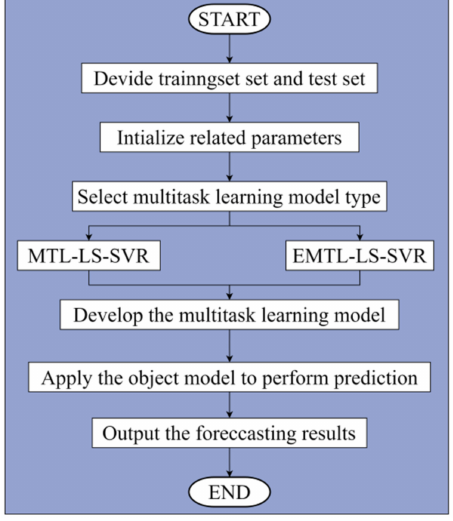
Figure 2. Flowchart of MTL-LS-SVR and EMTL-LS-SVR